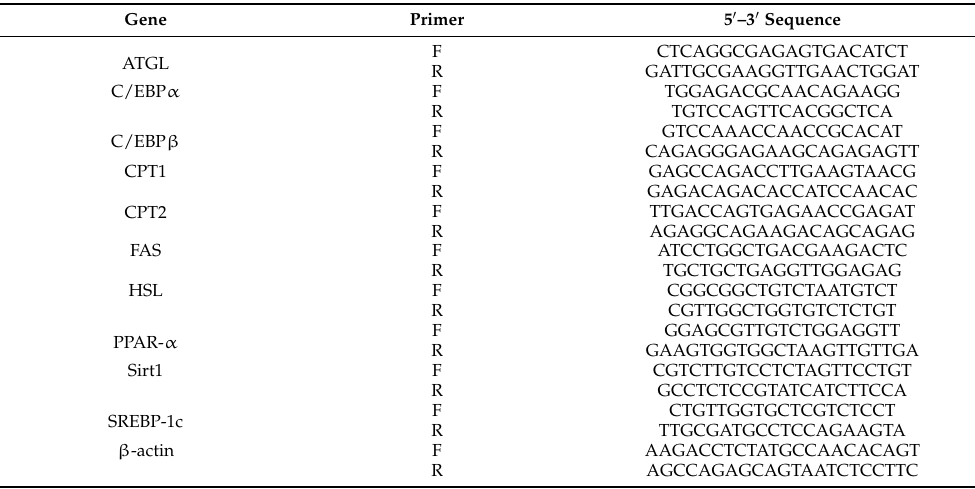
Table 1. Sequences of primer pairs used for real-time PCR. Forward (F); Reverse (R). Gene Primer 5 (cid:48) –3 (cid:48)